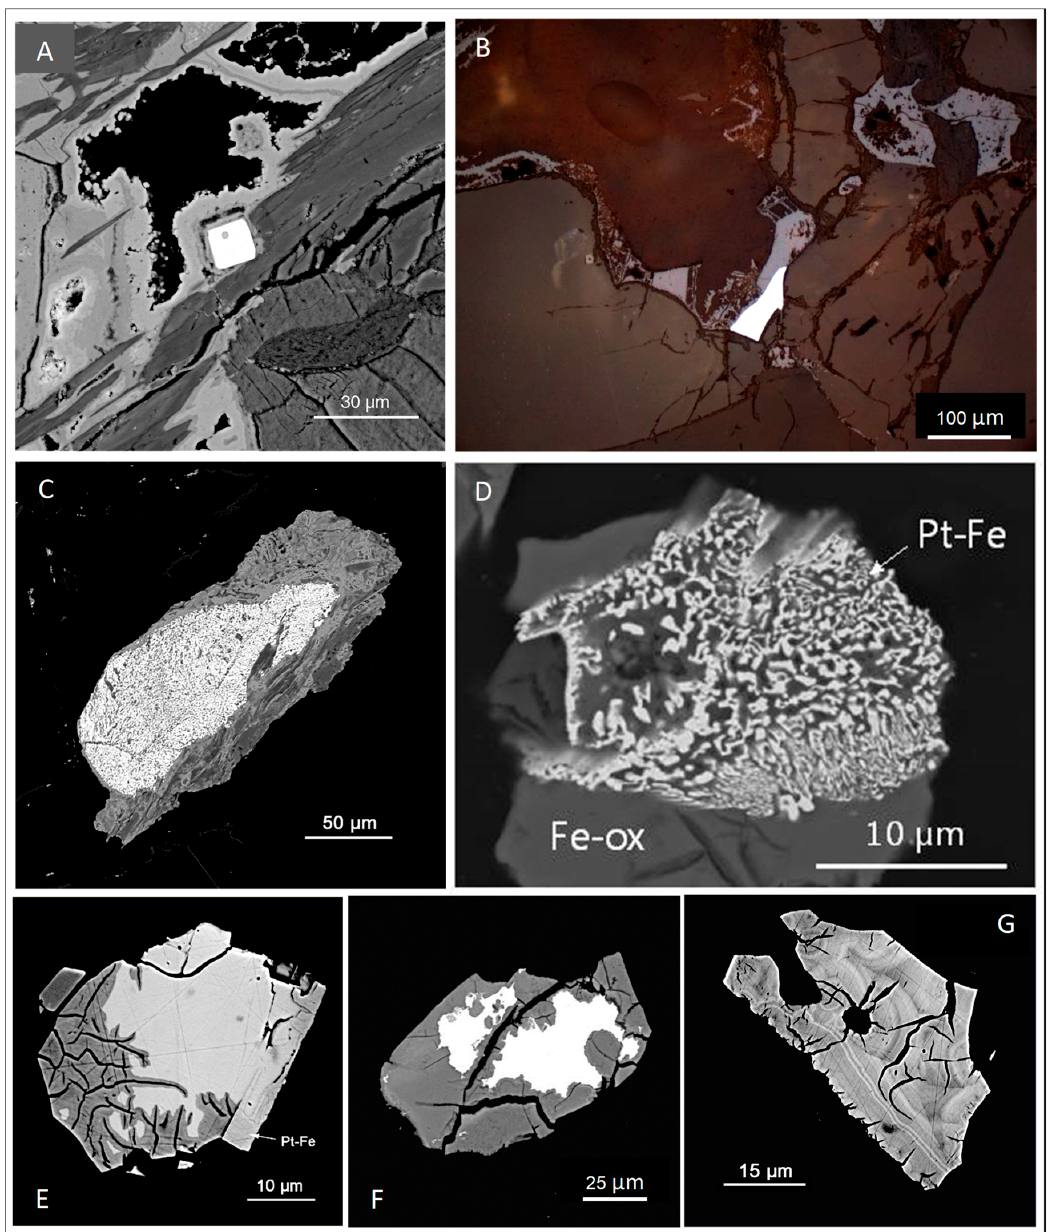
Figure 3. Relict platinum-group minerals, replacements, secondary formations, in oxidized ores. BSE images of polished sections, except ( B ) which is in reflected light. ( A ) Euhedral, relict sperrylite grain (white) in weathered MSZ ore consisting of iron-hydroxides (medium gray) and smectites (dark gray). HOP-05, ps 5663a, Hartley Mine. ( B ) Relict cooperite/braggite (white) surrounded by goethite (gray-bluish) and silicates (darkest phases). Merensky Reef, Richmond, eastern Bushveld [26]. ( C ) Porous grain of Pt–Fe alloy surrounded by a mixture of secondary oxides/hydroxides and silicates. HOP-206a, ps 5910a, Hartley Mine. ( D ) Pt–Fe phase of spongy texture intergrown with Fe hydroxide. Concentrate after hydroseparation, Hartley Mine. ( E ) Pt-bearing sobolevskite (light grey) being replaced by PGE-oxides/hydroxides (left and bottom). Note attached grain of Pt–Fe alloy (Pt–Fe). Adit A, Ngezi concession. ( F ) Grain of michenerite (white, center) in disintegration. Alteration rim (gray) of (Pt,Pd)-oxide/hydroxide phases shows Pd, Cu, and Fe as major elements. HOP-206a, ps 5910a, Hartley Mine. ( G ) Colloform, banded grain of PGE-oxide/hydroxide phase with shrinkage cracks. NGZ 1C, ps 5711b, from Adit A, Ngezi concession.